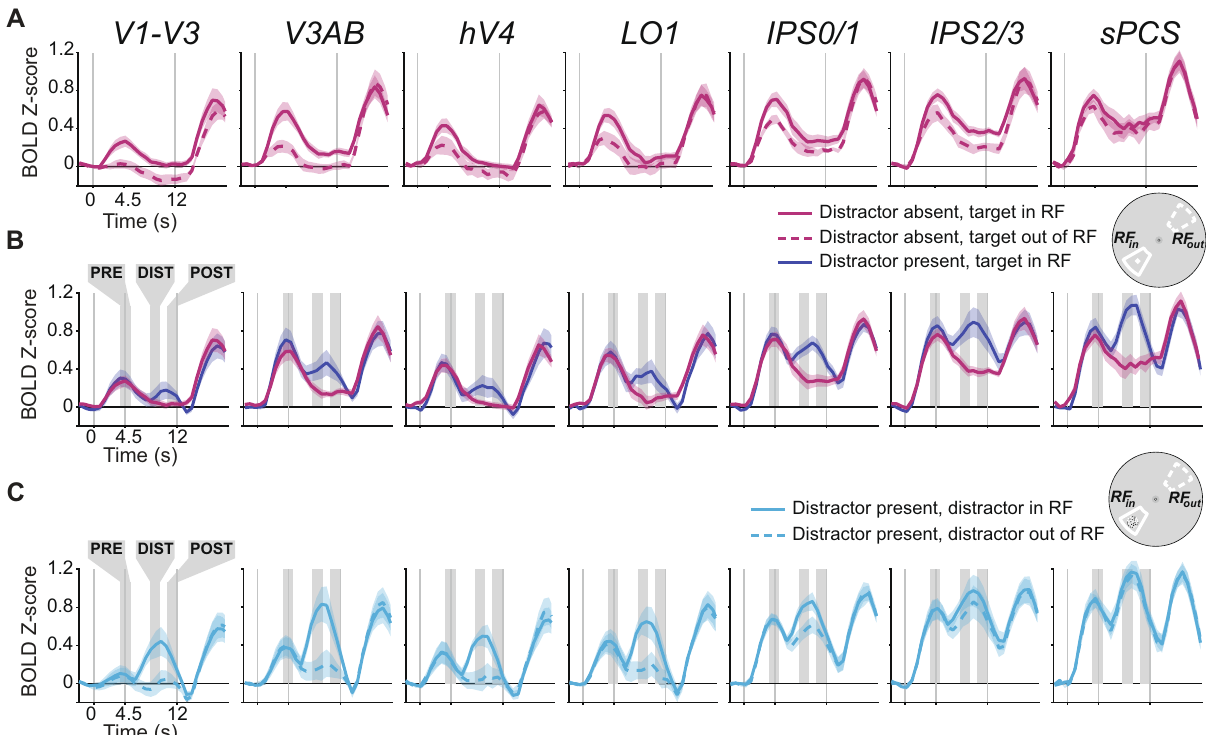
Fig. 2 BOLD responses sorted by voxel RF position during WM delay period. A During distractor-absent trials, the average (±SEM) amplitude of BOLD responses was greater in voxels whose receptive fi elds — estimated using nonlinear population receptive fi eld mapping 36 , see Fig. 3A for an example hemisphere) — aligned with the WM target (RF in ) compared to when the target was 180° away from voxels ’ receptive fi elds (RF out ). The inset to the right depicts an example of the RF in and RF out regions of the visual fi eld with respect to the WM target location (see Methods section for more details). The amplitudes of persistent activity increased moving anterior in the dorsal stream ROIs from early visual cortex (V1 – V3; V3AB) to parietal cortex (IPS0/1) to frontal cortex (IPS2/3), while the spatial selectivity (difference between RF in and RF out ) decreased. Data from ventral (hV4) and lateral retinotopic regions (LO1) is also included for completeness. Time series were baseline-corrected by removing the mean activation from − 2.25 to 0 s prior to delay period onset from each time series. B During distractor-present trials, we observed an additional phasic response time-locked to the distractor onset across all ROIs. C To further illustrate the distractor response, we averaged the BOLD responses in voxels whose RFs were aligned to the distractor position, regardless of the position of the WM target. The phasic responses were more robust in voxels with RFs that matched (RF in ) compared to opposite to the distractor (RF out ). The shaded areas denote the pre-distractor, distractor, and post-distractor epochs that are the target of later analyses. Results for individual ROIs shown in Supplementary Fig. 2, along with visualized voxel RF parameters, and all p -values are available in Supplementary Table